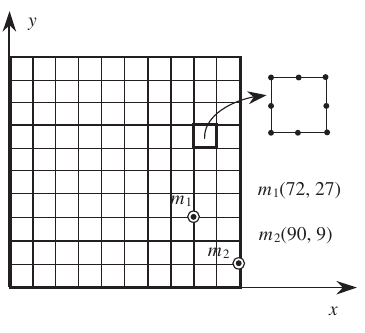
Figure 4: Finite element mesh of square FGM plane structure (measurement locations are indicated by the heavy circle).